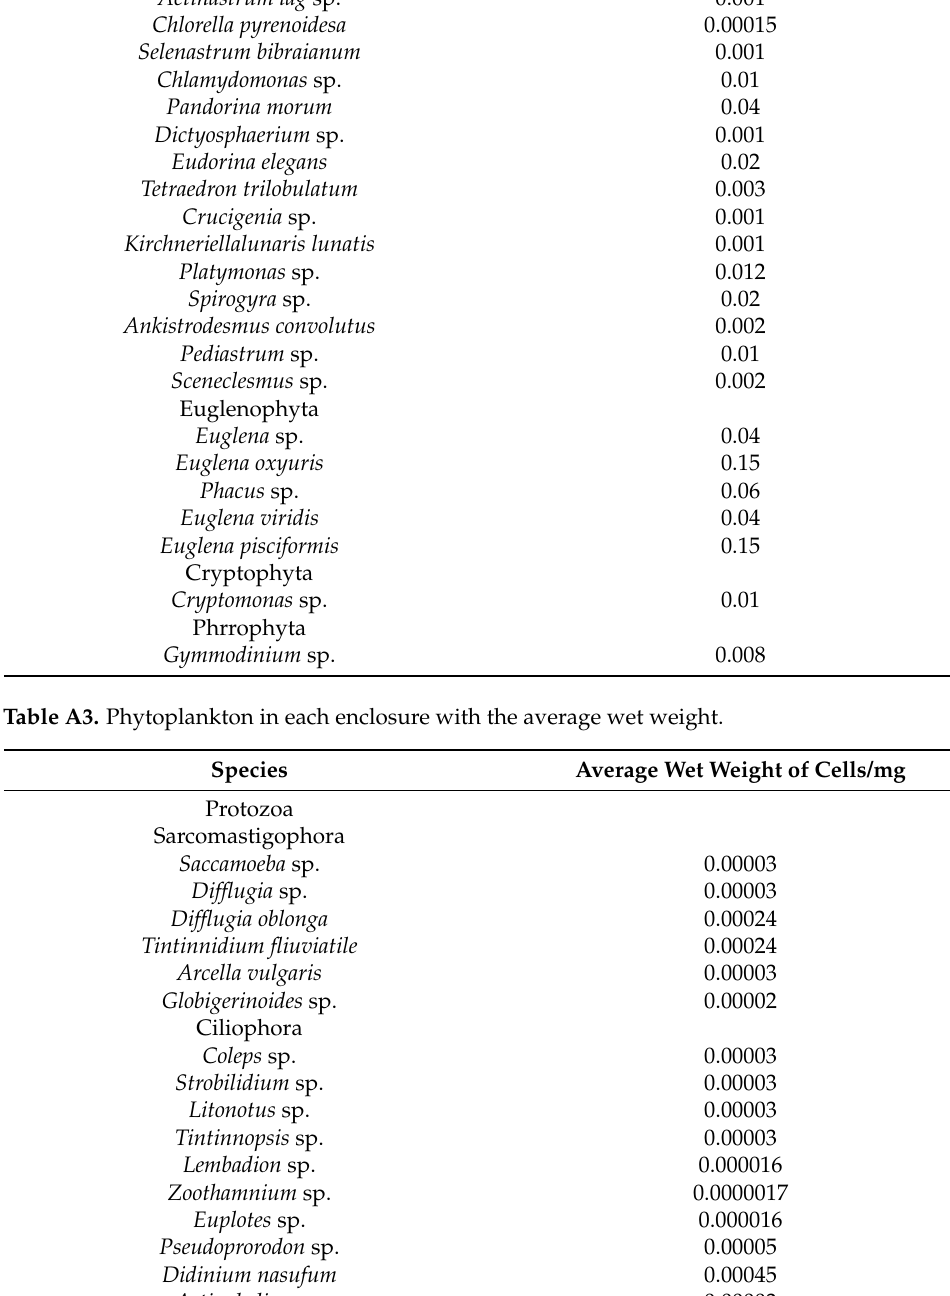
Species Closterium sp.